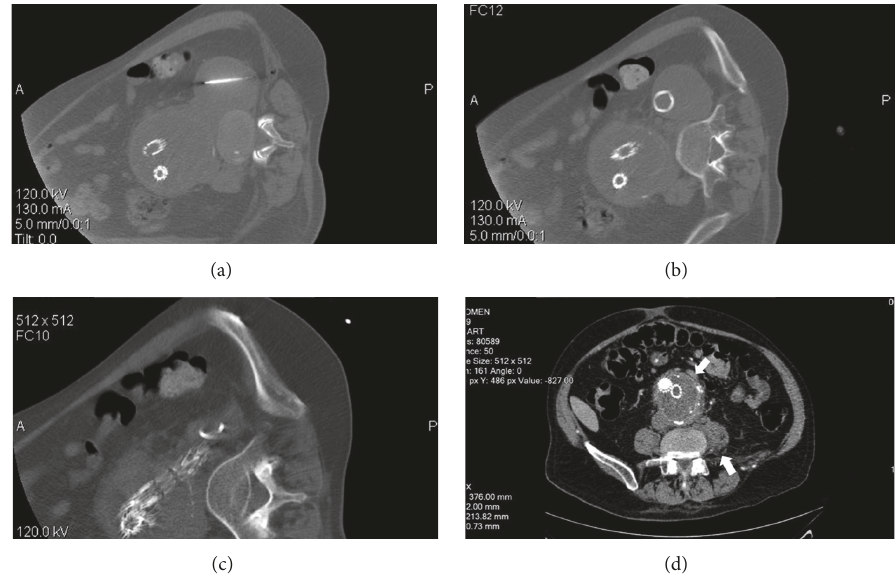
Figure 3: Drainage of hematoma under CT guidance: (a) guide trocar inserted from lumbar (b) pigtail in place drains the hematoma; (c) immediate shrinkage of hematoma cavity; (d) left iliopsoas muscle with almost normal shape (upward arrow) and reduction of remaining aneurysm sac (downward arrow) in a follow-up CT imaging four months